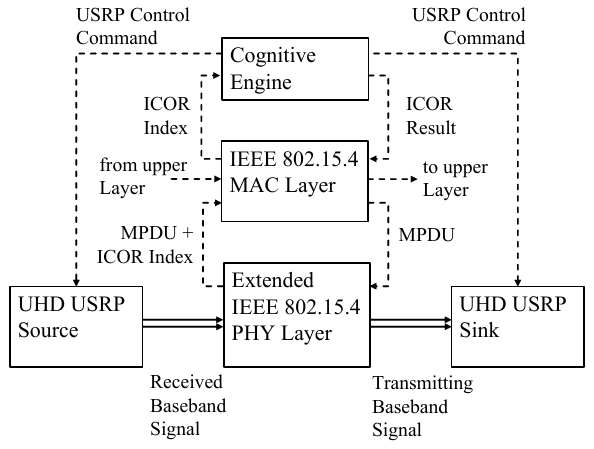
Figure 11. Cognitive IEEE 802.15.4 transceiver implemented in GNU Radio